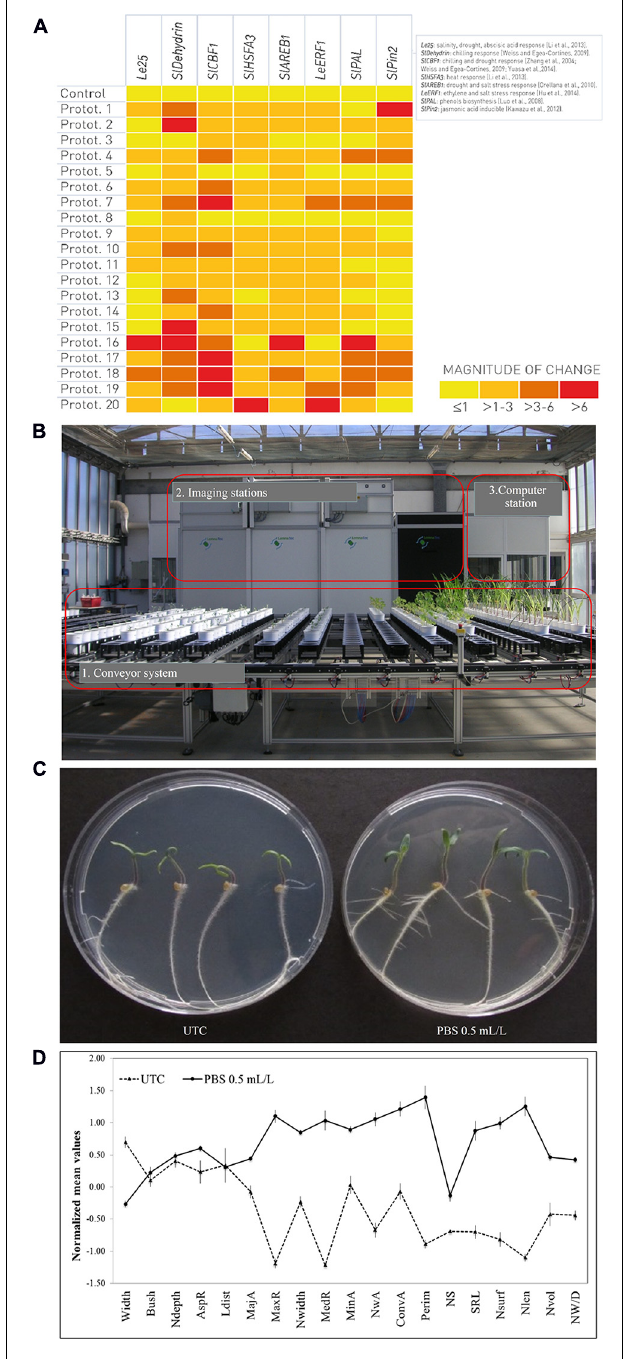
FIGURE 2 | Genomic, phenomic, and in vitro platforms to screen the effect of a set of different natural extracts-based prototypes using tomato ( Solanum lycopersicum L.) cv. Microtom as plant model. (A) Relative abundance of mRNA transcripts of markers for specific physiological processes in response to a range of treatments with biostimulant prototypes (Protot.). Transcript levels (signal intensities) are presented in the form of a heat-map (using HeatMapper Plus Tool), on a color scale between low (yellow) and high (red). (B) LemnaTec-Scanalyzer 3D System placed at ALSIA – Metapontum Agrobios Research Center (Matera,